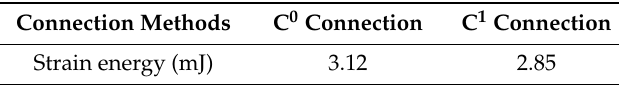
Table 2. Strain energy in